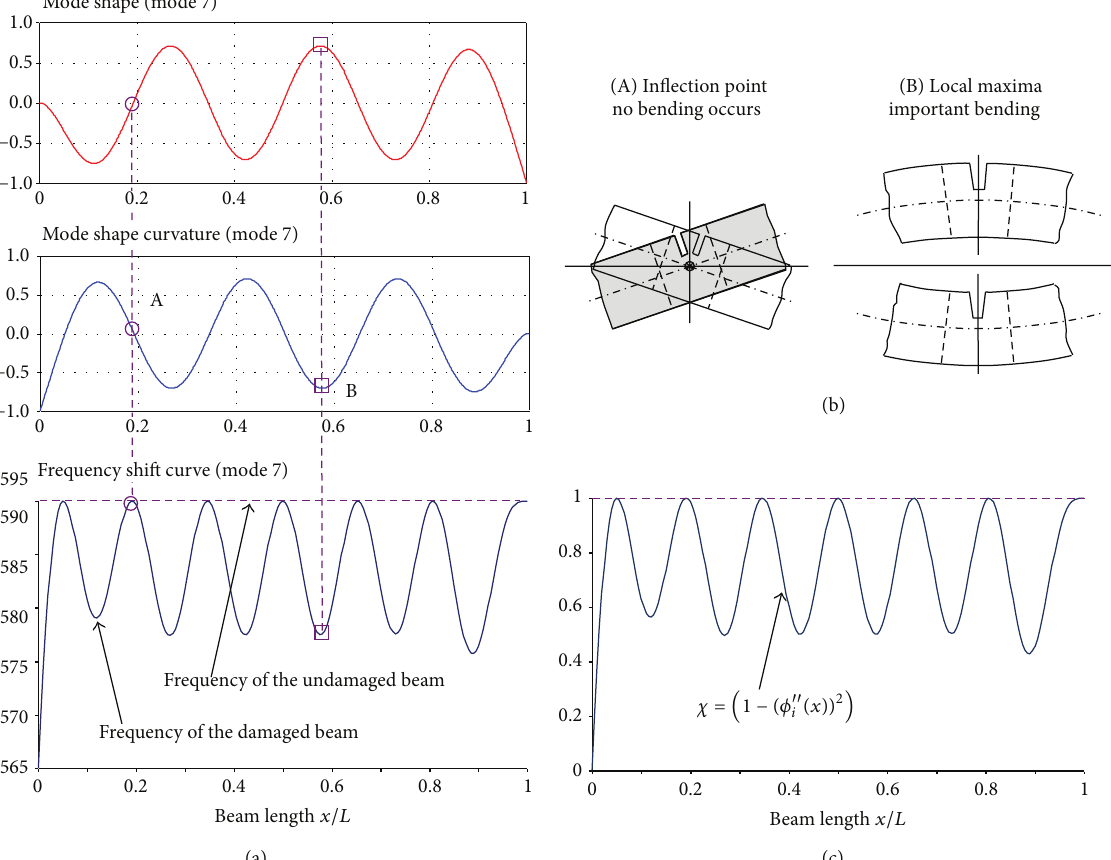
Figure2:(a)Modeshapes,curvature,andnaturalfrequencyshiftcurvesforbendingmode7,(b)thebehaviorofslicesplacedoncharacteristic point on the beam, and (c) the representation of function 𝜒 for the same bending vibration